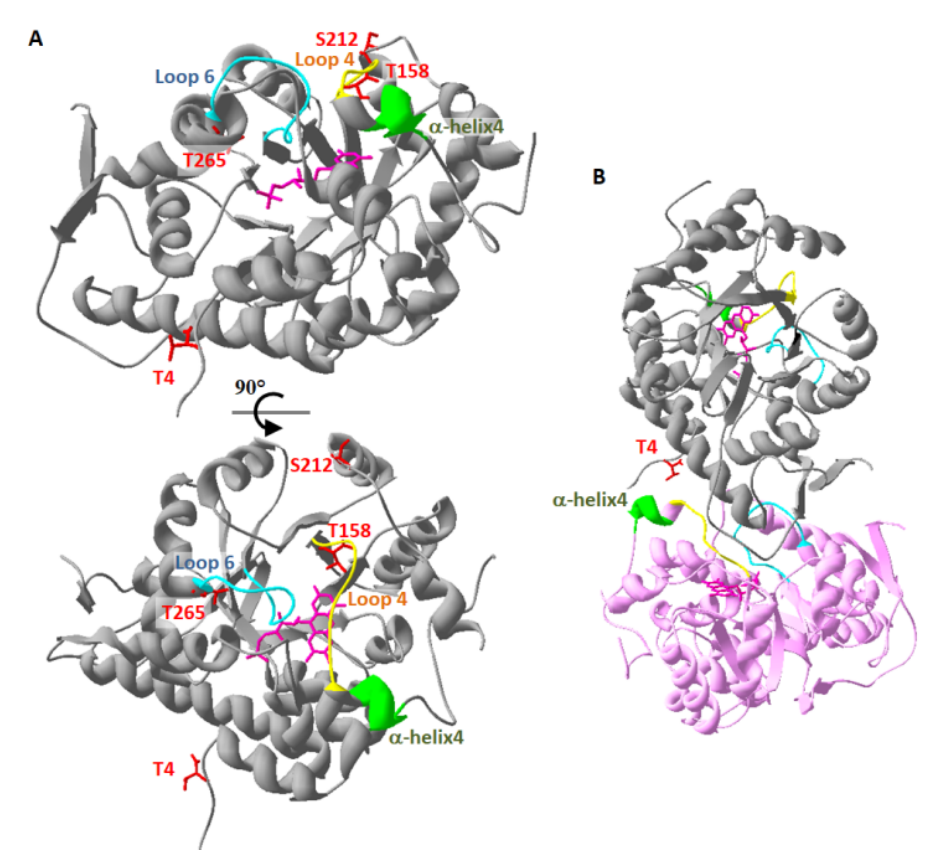
Figure 2. Localisation of phosphorylated residues and important structures of At GOX1. A structural model of At GOX1 based on the 3D-structure of spinach GOX [31]. ( A ) At GOX1 monomer showing phosphorylated residues T4, T158, S212 and T265 (red), loops 4 (yellow) and 6 (blue), α -helix4 (green) and the flavin mononucleotide (FMN) (pink). The bottom structure is rotated by 90 ◦ with respect to the top structure. ( B ) View of two At GOX monomers (in grey and in pink) and the proximity between T4 (red) of a GOX subunit with α -helix4 (green) of a neighbouring GOX subunit.